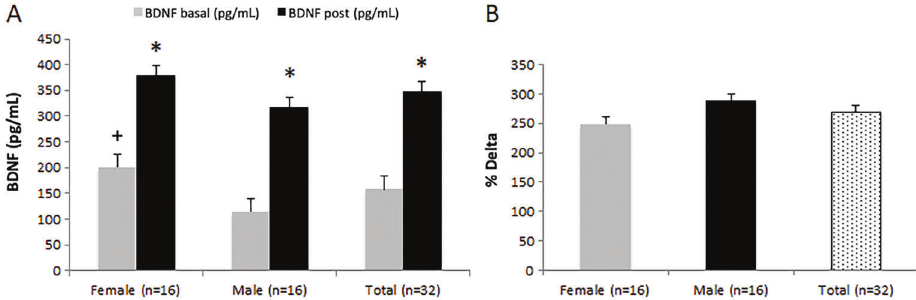
Figure 3. Plasma brain-derived neurotropic factor (BDNF) before (basal) and after maximal incremental ramp test. A , Basal BDNF was higher in females than in males (P=0.014). Increase in BDNF levels was observed in the whole sample (P o 0.0001) as well as in females (P=0.0004) and males (P o 0.0001). B , No signi fi cant difference was found in delta BDNF between females and males (P=0.393). Data are reported as means ± SE. *Statistically signi fi cant difference between rest and after training session; + statistically signi fi cant difference between males and females (Mann-Whitney and Student ’ s t